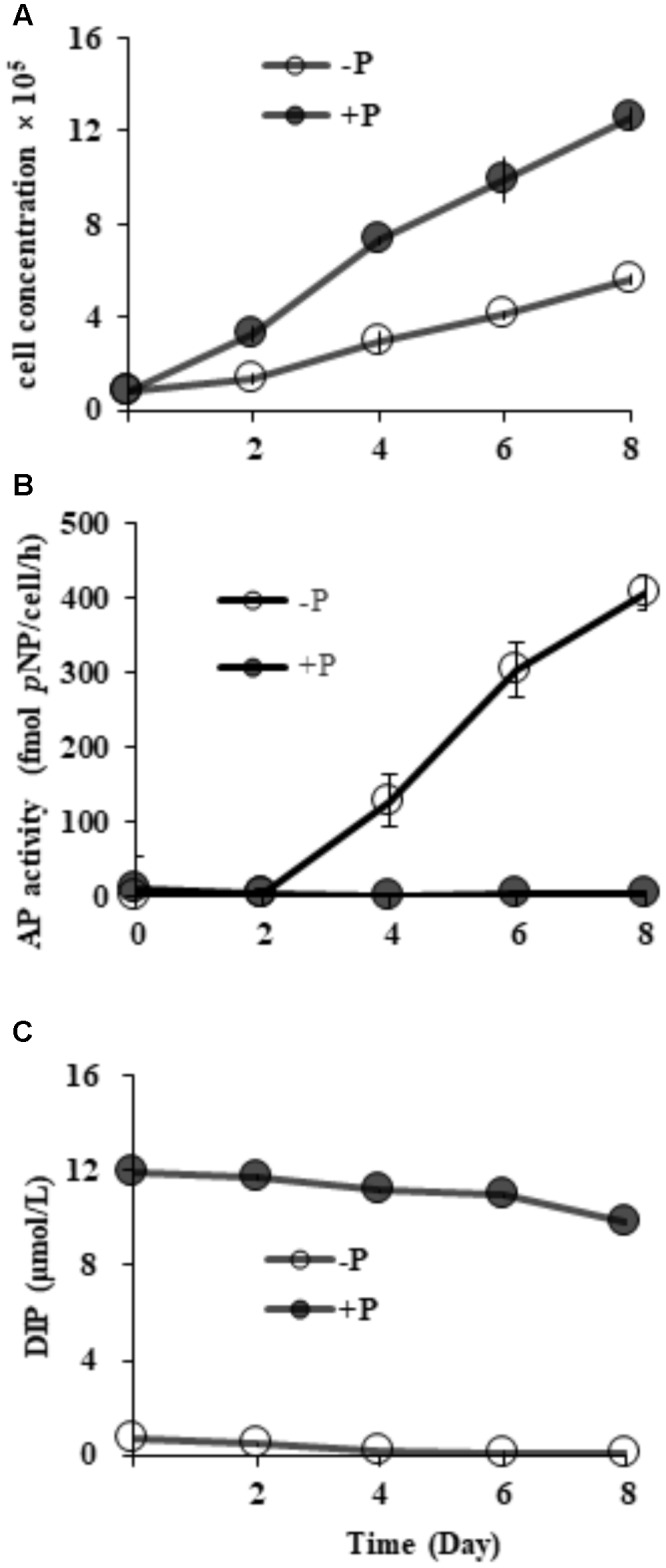
Growth curves (A), AP activity (B) and dissolved inorganic phosphorus (DIP) concentrations (C) in P-replete and P-depleted cultures. Shown are means ± standard deviations (error bars) from the triplicated cultures.